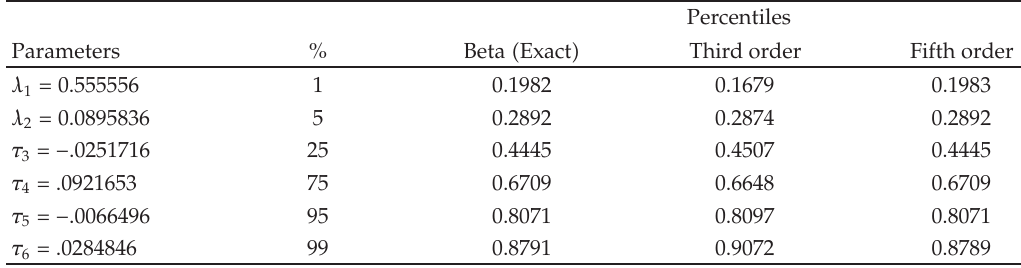
Table 3: L -moment parameters (cid:2) λ,τ (cid:3) and percentiles for the Beta (cid:2) α (cid:7) 5 ,β (cid:7) 4 (cid:3) distribution and power method approximations in Figure